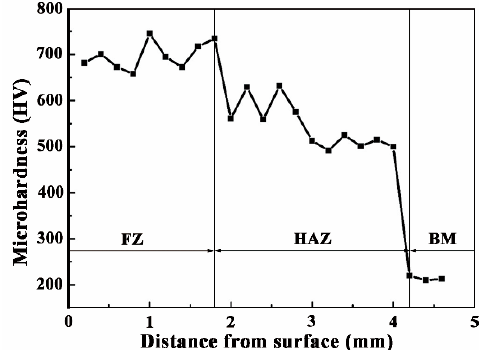
Figure 9. ( a ) Microhardness and ( b ) Rockwell hardness of the CZ and S.